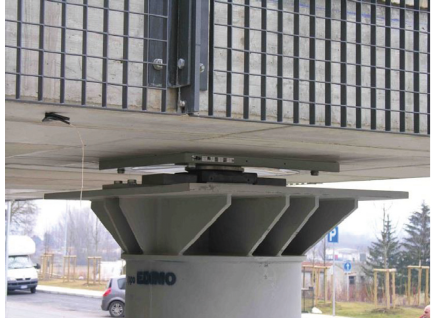
Figure 2: Single curved surface